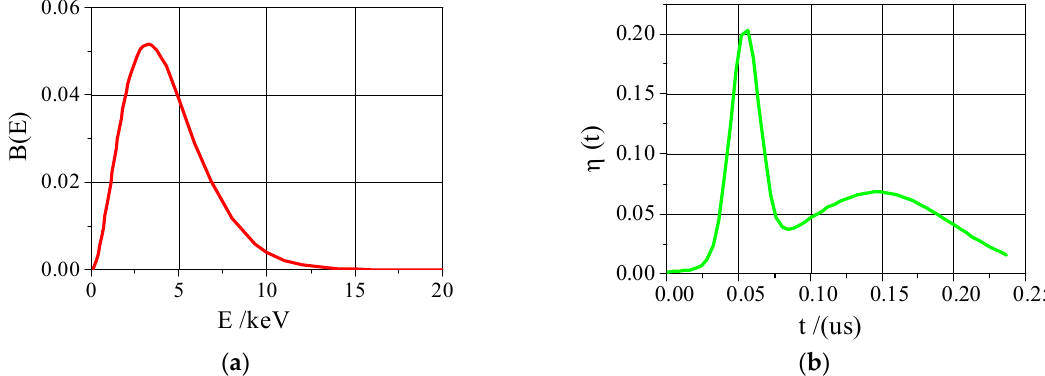
Figure 1. The normalized energy spectrum and time spectrum of intense pulse X-ray. ( a ) energy spectrum; ( b ) time spectrum.